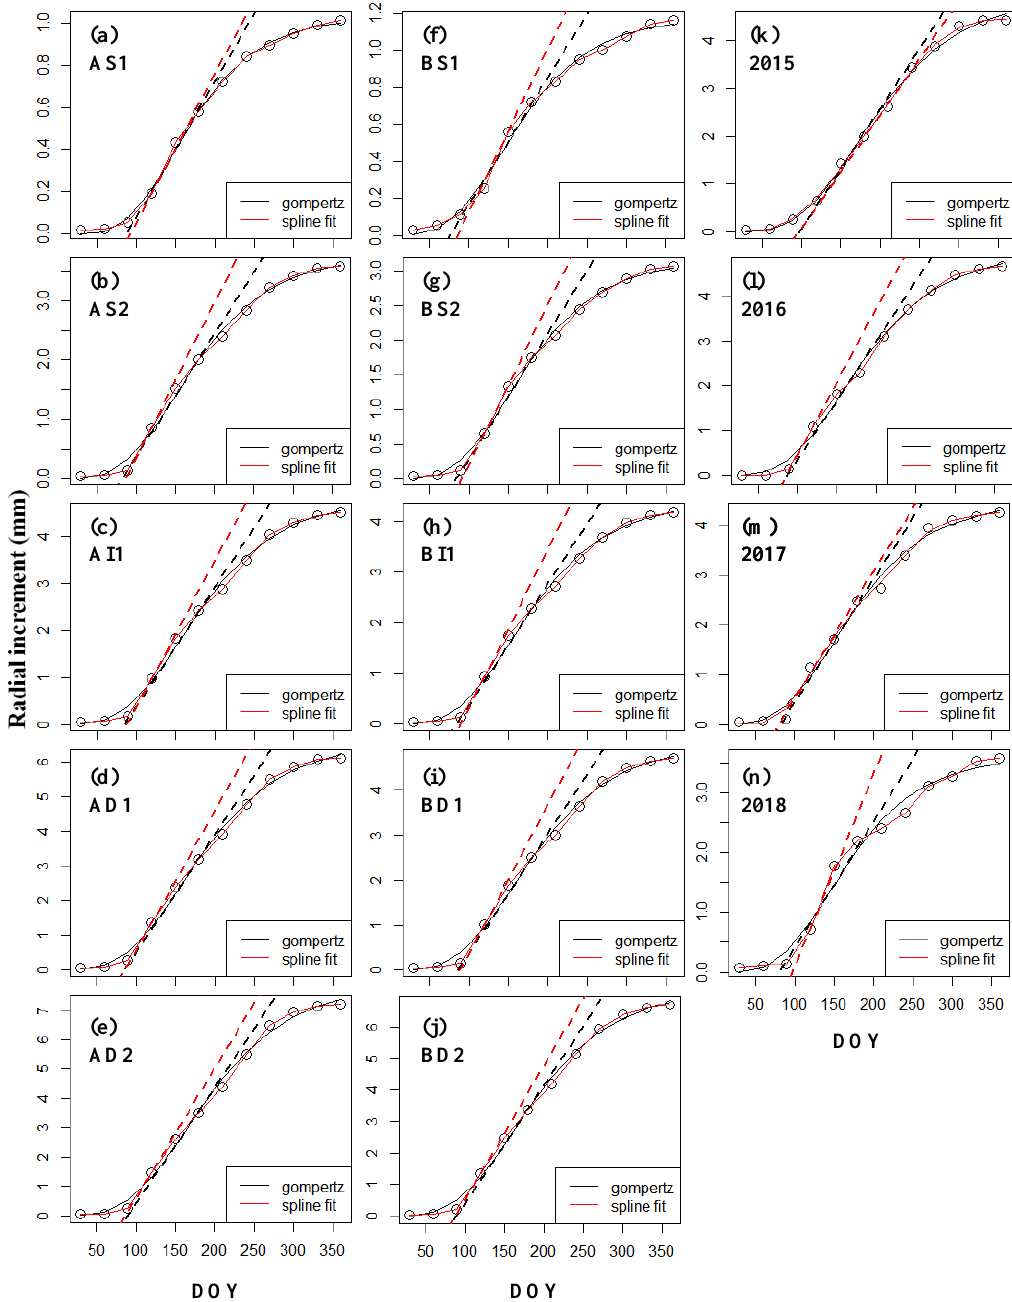
Figure 4. Estimated radial growth curves by the Gompertz model for Chinese fir (solid line) and the maximum slope (dash line) throughout a year: ( a – e ) Considering the tree groups in site A, ( f – j ) considering the tree groups in site B, and ( k – n ) considering the studied years. Note: DOY means day of the year.